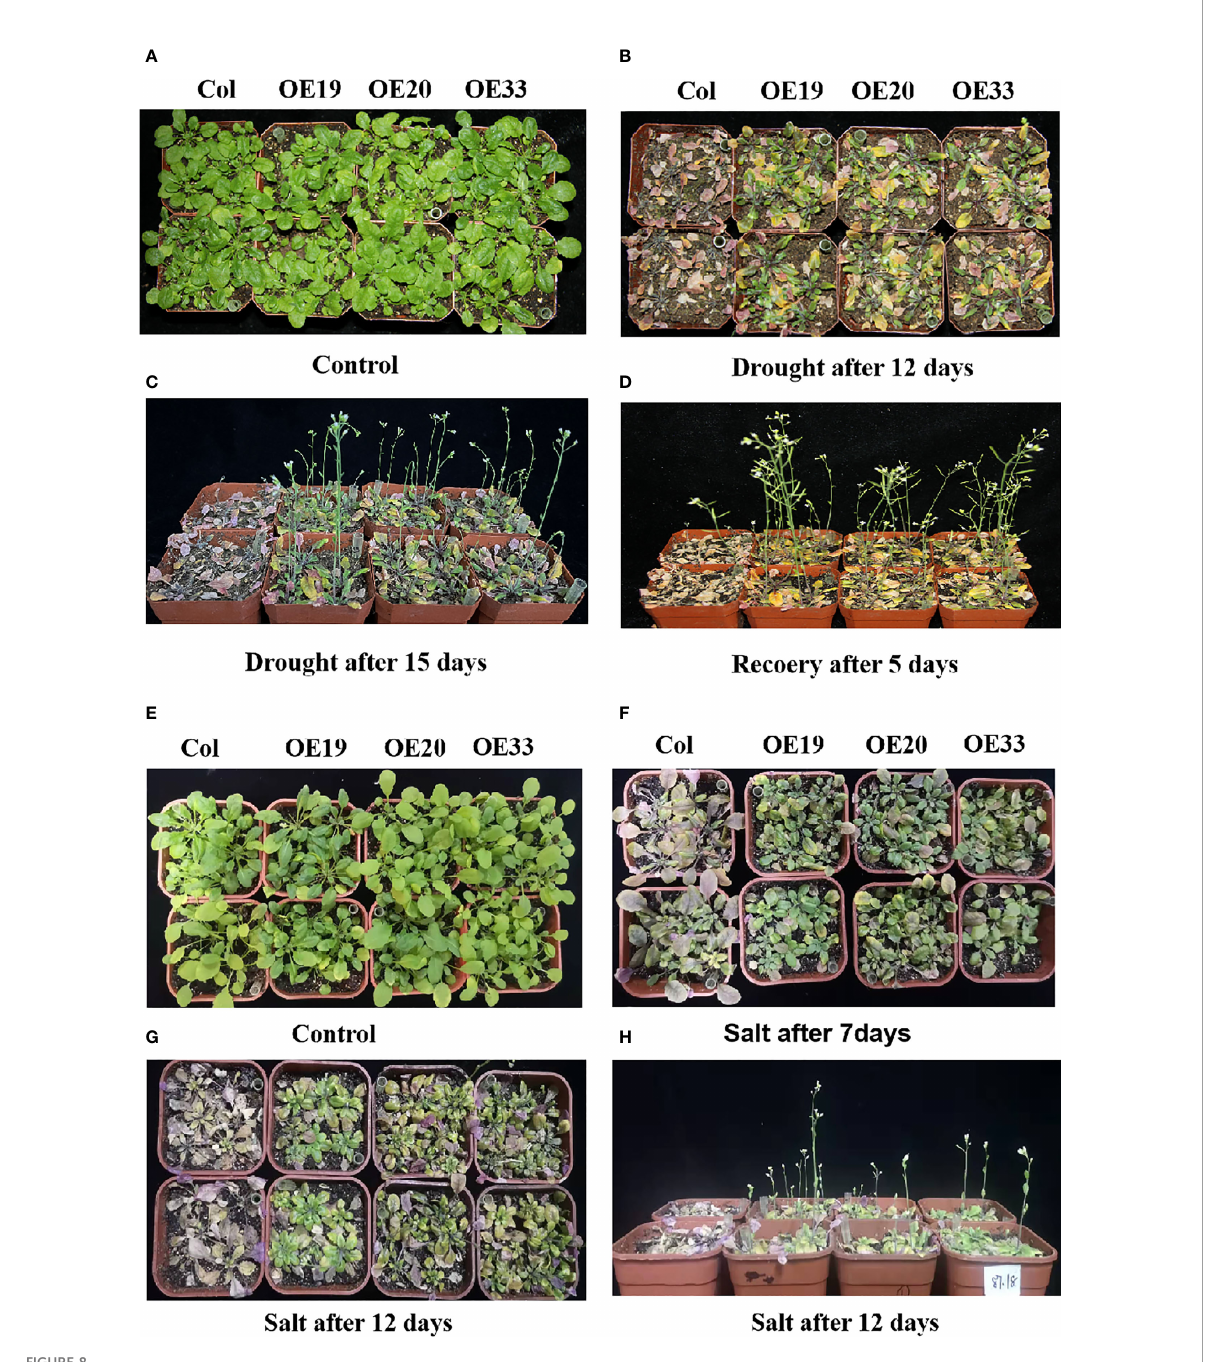
FIGURE 8 Phenotype of MfERF053 transgenic overexpression Arabidopsis under drought NaCl and treatment in soil. (A-D) , The phenotype of wide type and transgenic of Arabidopsis under normal (A) , drought after 12 days (B) , drought after 15 days (C) and recover after 5 days (D) , respectively. (E- H) : The phenotype of wide type and transgenic of different strains of Arabidopsis under normal (E) , salt after 7 days (F) , salt after 12 days (H) and salt after 12 days (I) ,